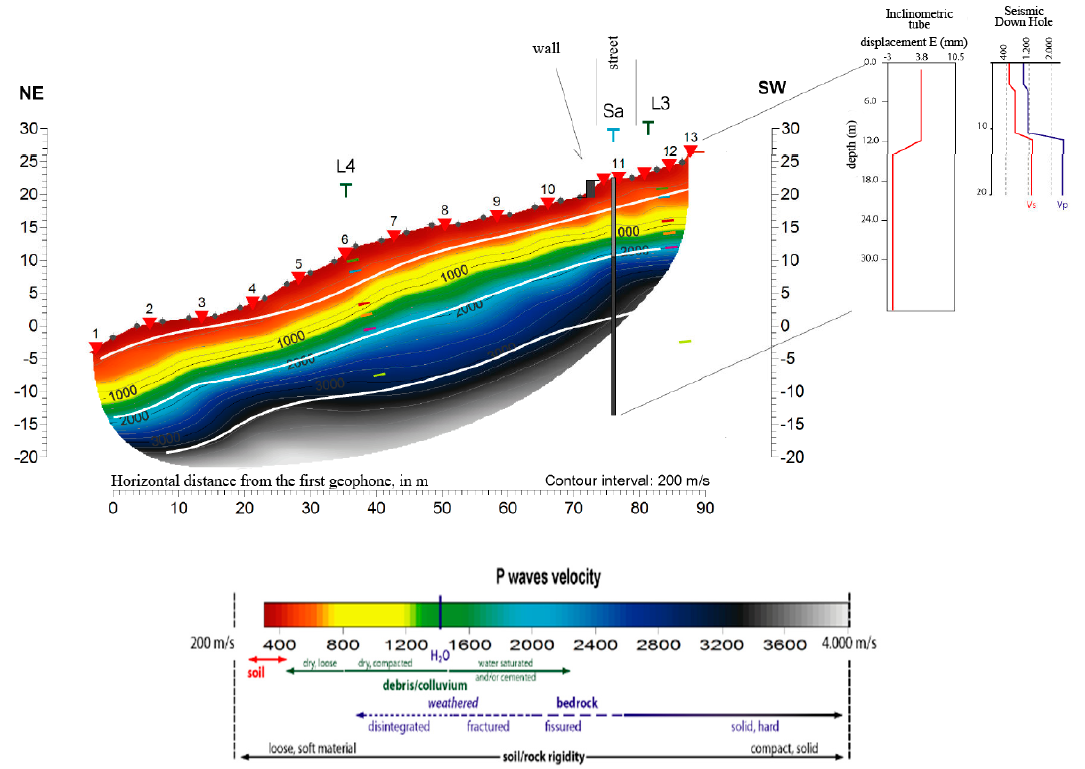
Figure 11. P-wave propagation rate according to surficial refraction tests compared with inclinometer lectures and down-hole profiles.